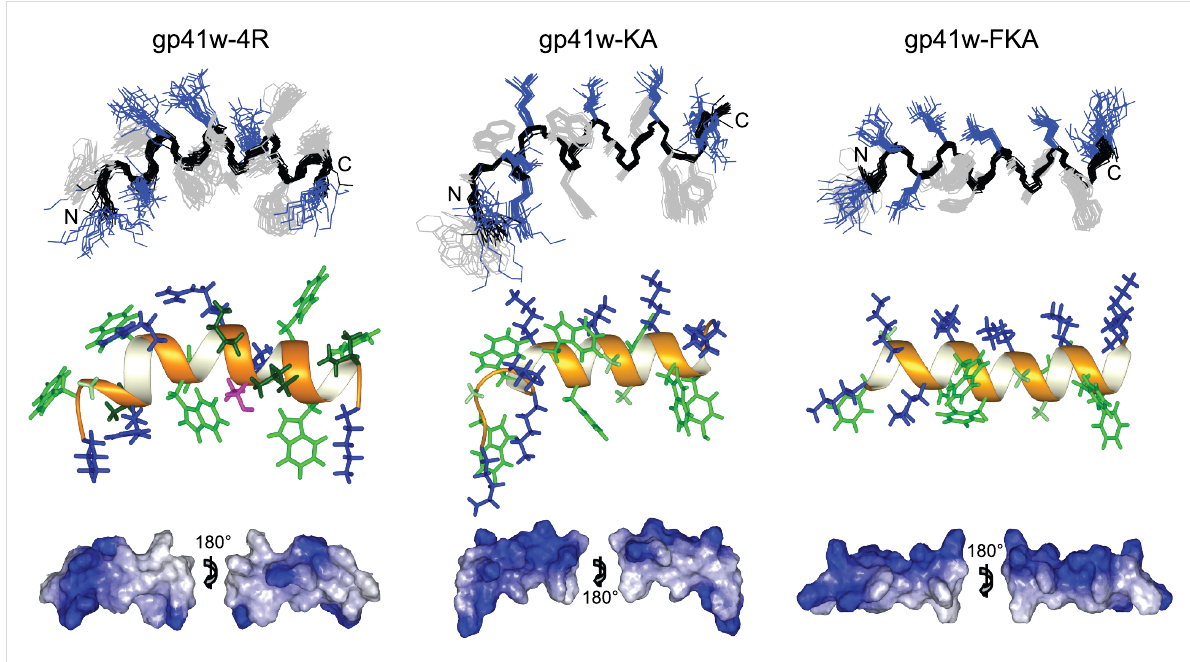
Figure 7: NMR solution structure of gp41w-4R, gp41w-KA and gp41w-FKA in the cosolvent mixture. Overlay of the 20 lowest-energy structures reveals a well-defined backbone conformation for all three peptides (top panel). All the peptides adopt a largely helical conformation as seen in the ribbon diagrams (middle panel). The hydrophobic residues (green) and the cationic residues (blue) are shown along with Thr12 (magenta) in gp41w- 4R. The gp41w-4R peptide lacks distinct amphipathicity, while gp41w-KA and gp41w-FKA have much more pronounced amphipathic character across the length of the helix (bottom panel, positively charged regions are indicated in